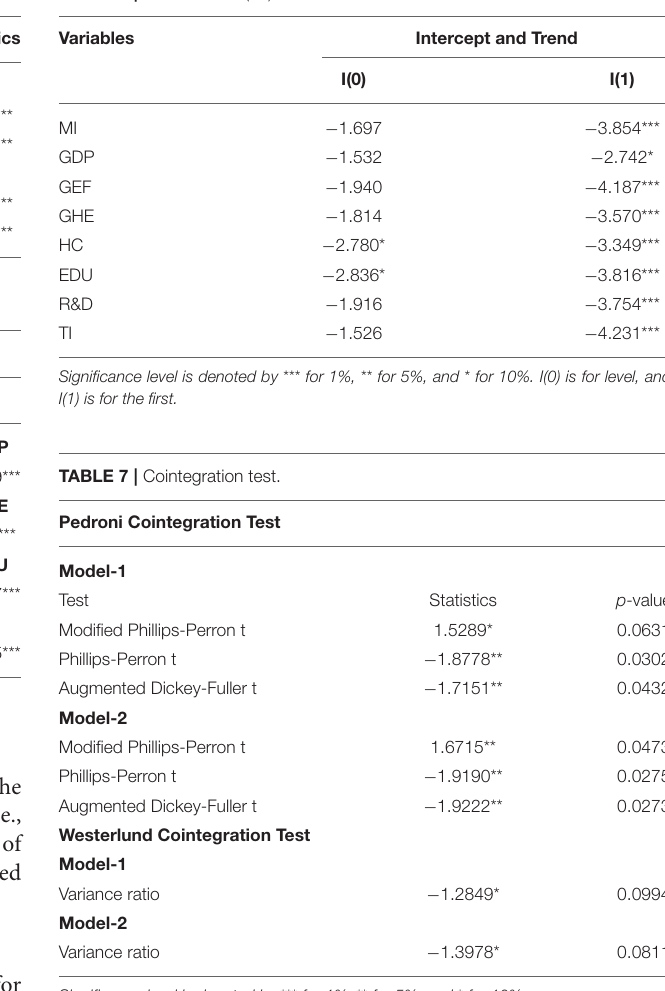
TABLE 6 | Unit root test (41).